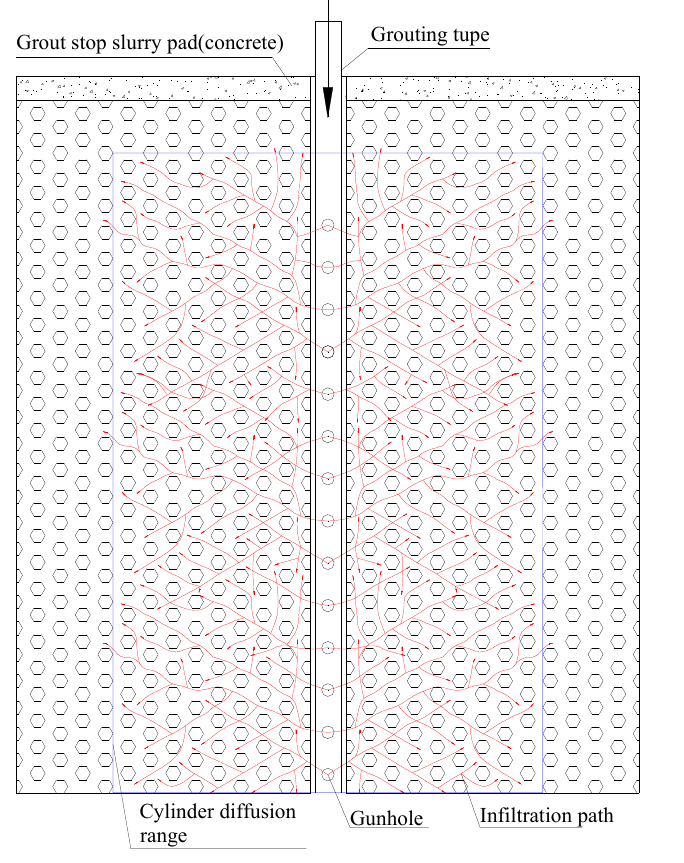
Figure 1. Conceptual model of cylinder diffusion in permeable grouting.